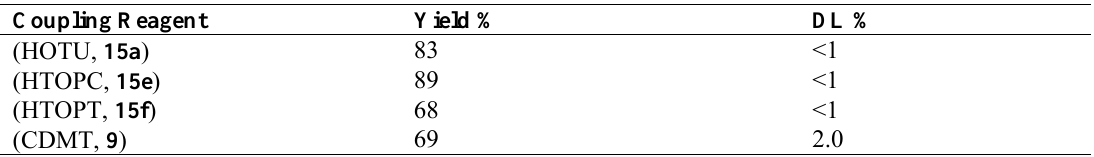
Table 2. Yield (%) and Racemization (%) of Z -Phe-Val-OMe ( 16b ) using the Uronium Salts 15a,e,f and CDMT ( 9 ).